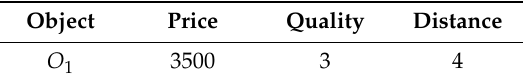
Table 3. First filtering object of P 1 .